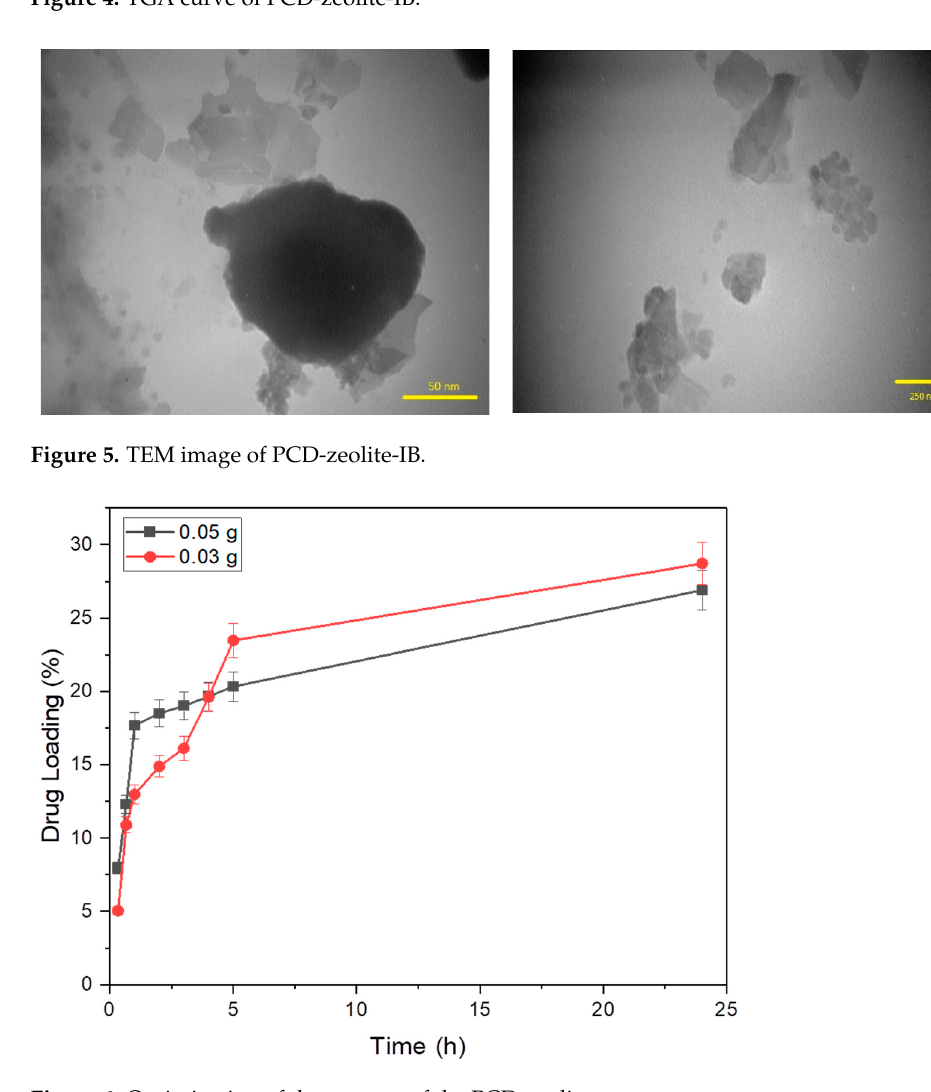
Figure 6. Optimization of the amount of the PCD-zeolite.